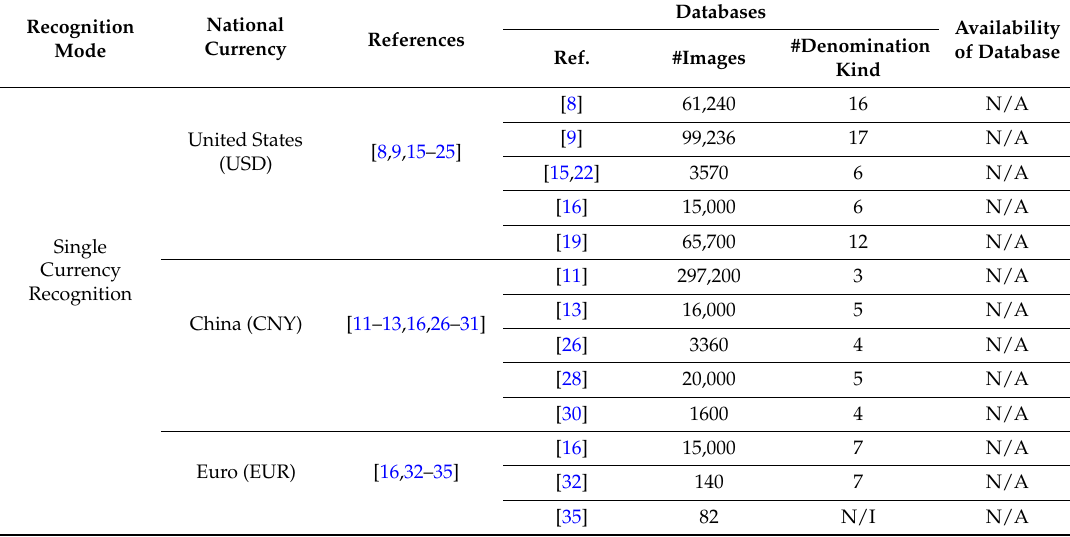
Table 1. Studies on banknote recognition by national currency (Ref.: Reference(s), N/I: No Information, A: Available, N/A: Not Available).